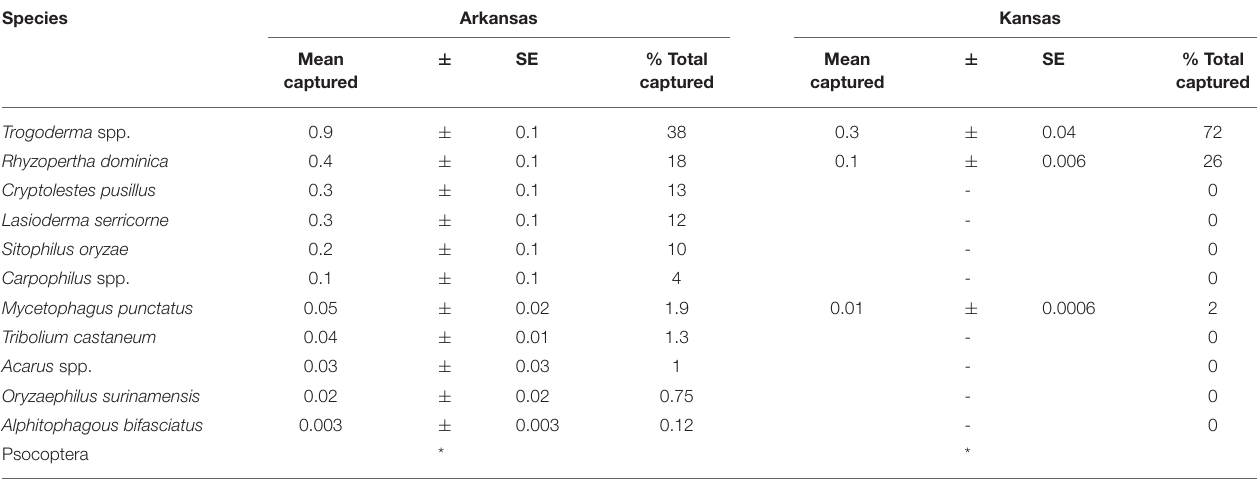
TABLE 3 | The community composition of stored product arthropods captured in interception traps deployed from 17 August 2018 at three sites in KS, and from 25 April 2019 to 18 September 2019 at three commercial sites in KS and 31 May 2019 to 30 September 2019 at three commercial sites in AR. Species Arkansas